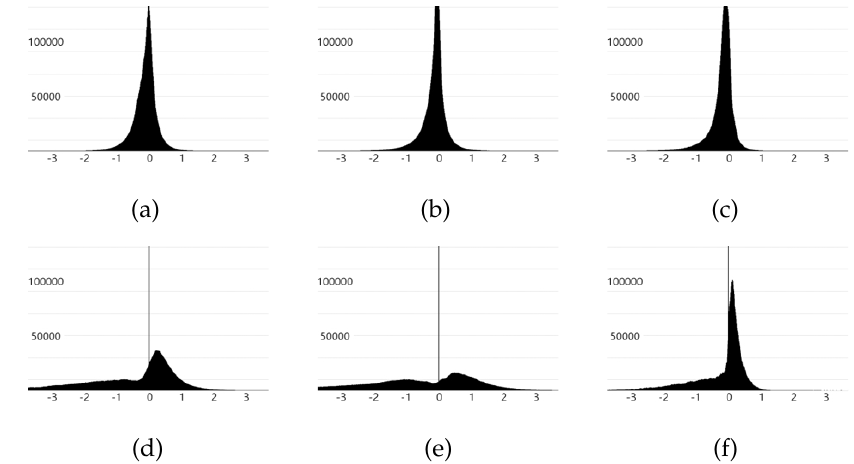
Figure 3. Comparison of the distribution as a histogram for data generated before ReLU in L 6 , L 11 and L 16 layers. ( a ) VDSR ( L 6 ), µ = − 0.09, σ = 0.17. ( b ) VDSR ( L 11 ), µ = − 0.12, σ = 0.25. ( c ) VDSR ( L 16 ), µ = − 0.19, σ = 0.23. ( d ) Proposed method ( L 6 ), µ = − 0.61, σ = 2.85. ( e ) Proposed method ( L 11 ), µ = − 0.97, σ = 6.01. ( f ) Proposed method ( L 16 ), µ = − 0.28, σ = 0.89.